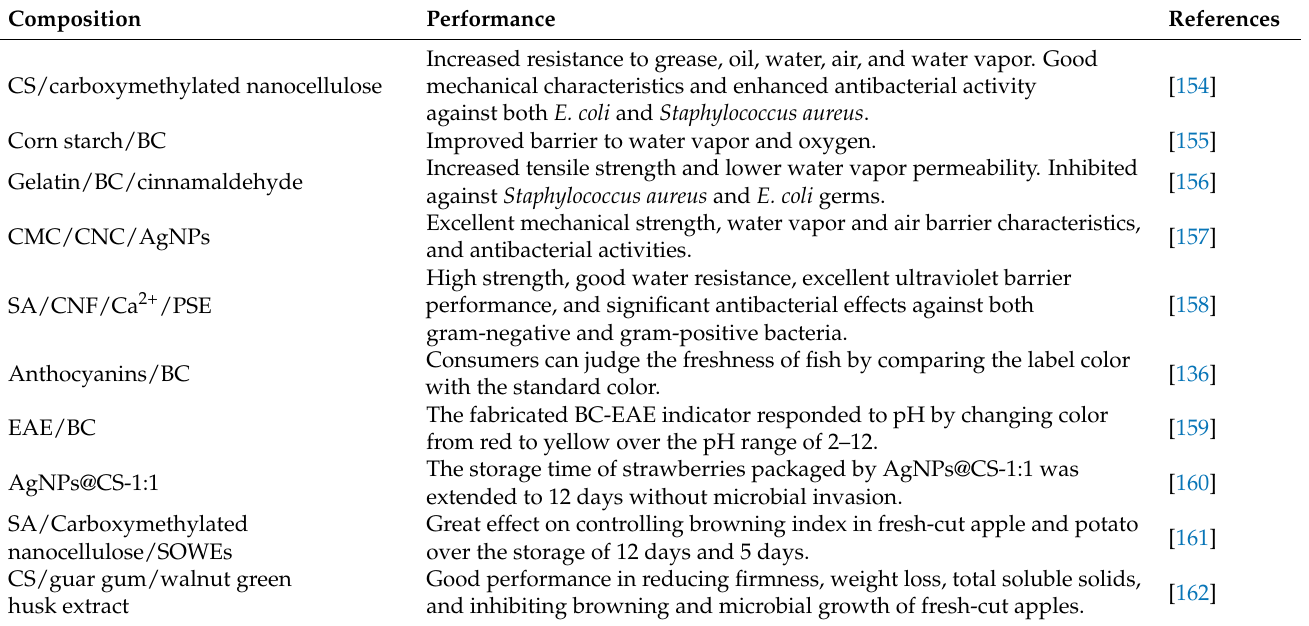
Table 5. Application and performance of nanocellulose-based food packaging